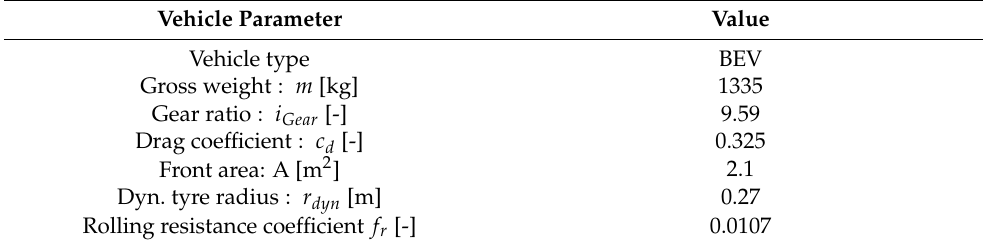
Table 1. Vehicle parameters for longitudinal model.